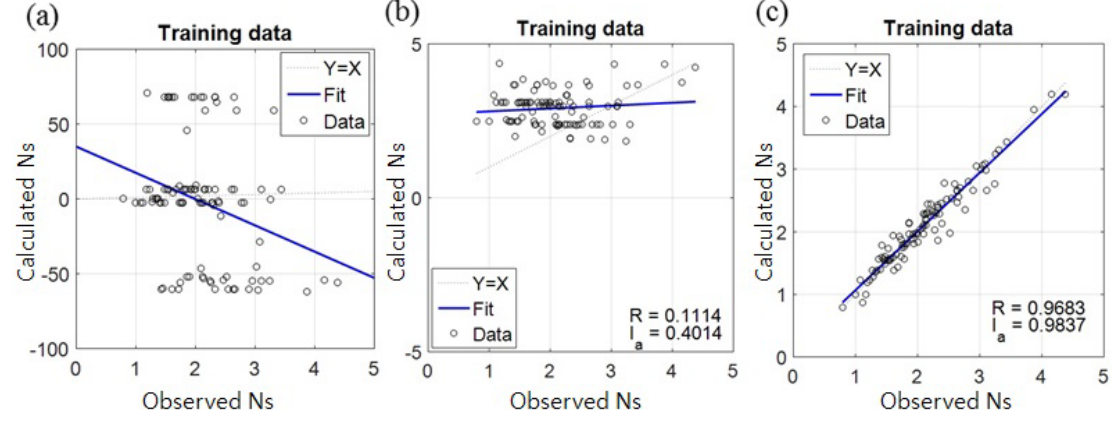
Figure 8. Same as Figure 7 but for Case 2 (HMCR = 0.1; PAR = 0.5).